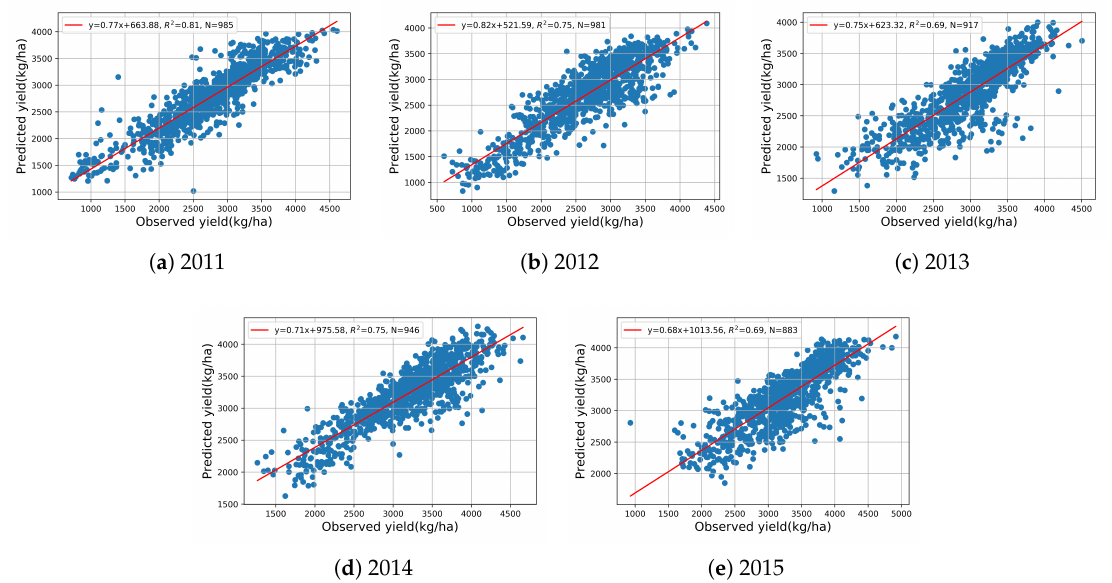
Figure 6. Scatter plots of end-of-season predicted vs. observed yield from 2011 to 2015.